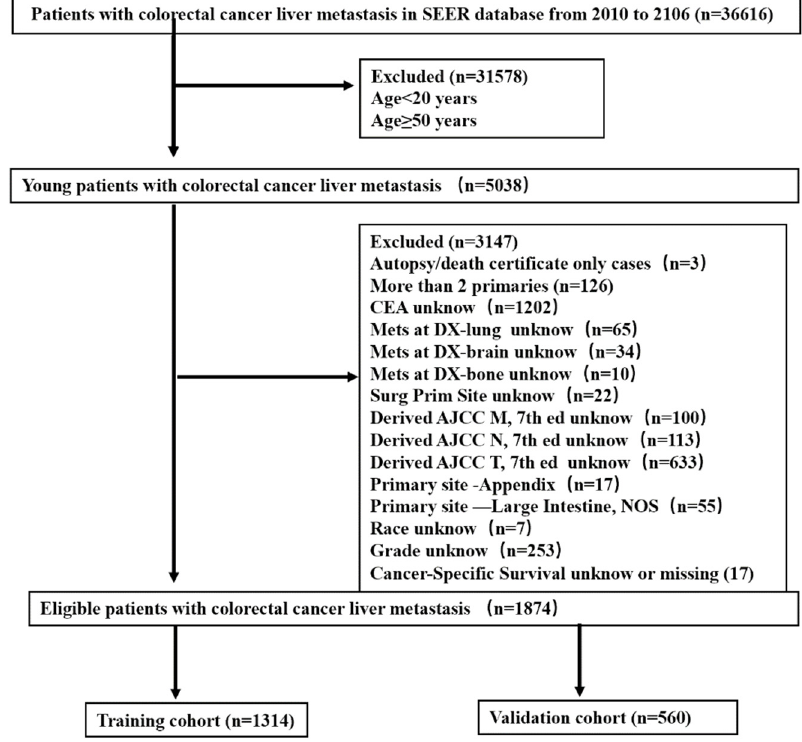
Figure 1. Strategies for selecting patients to be included in the study.